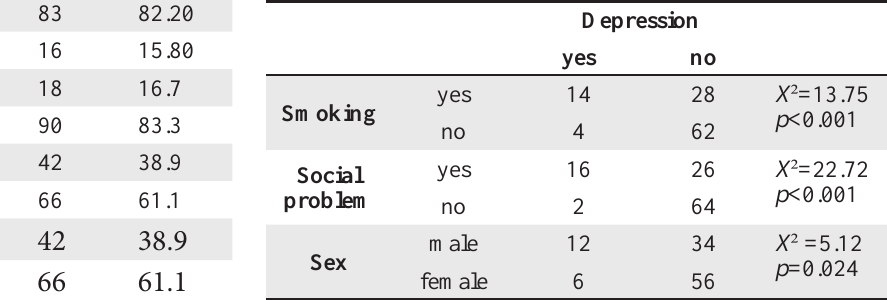
Table 3 : Relation of Depression with smoking, social problem and